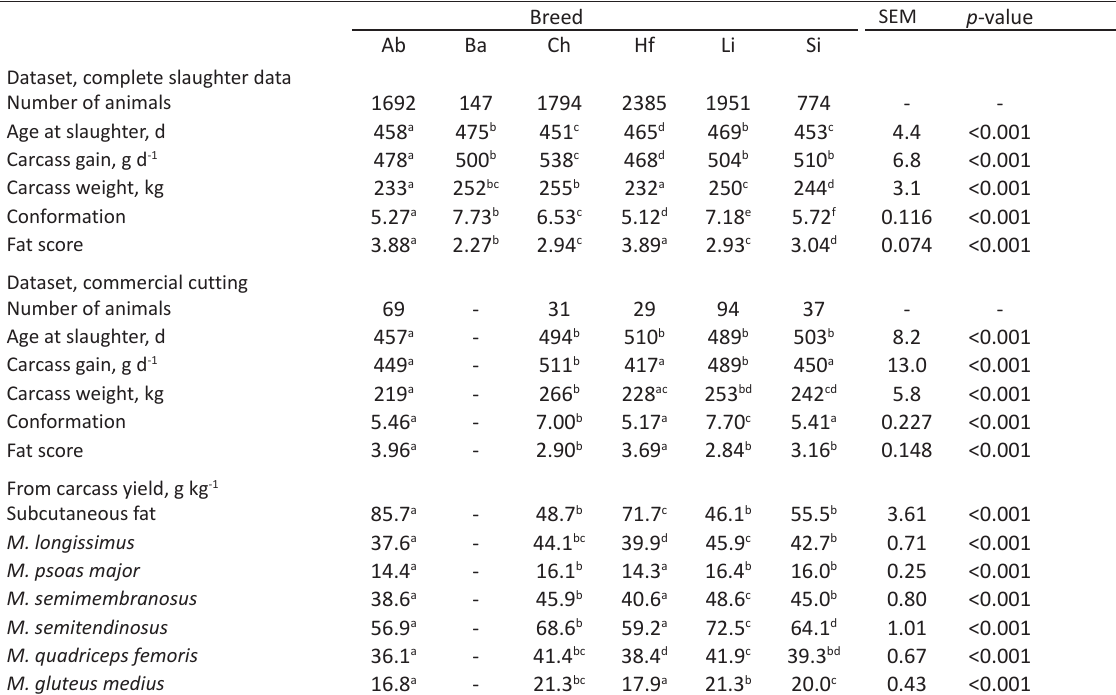
Table 3. Carcass gain, carcass characteristics and valuable cuts of Aberdeen Angus (Ab), Blonde d’Aquitaine (Ba), Charolais (Ch), Hereford (Hf), Limousin (Li) and Simmental (Si) heifers in Finnish slaughter dataset. Between-breeds comparisons (Tukey, p <0.05): estimated means with the different letters were significantly different ( p